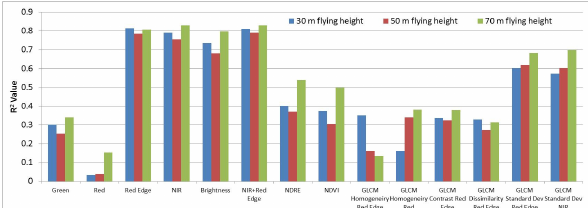
Figure 5. Relationship between field measured PPC and image derived spectral bands, indices and texture measures produced from imagery collected at 30, 50 and 70 m flying height.